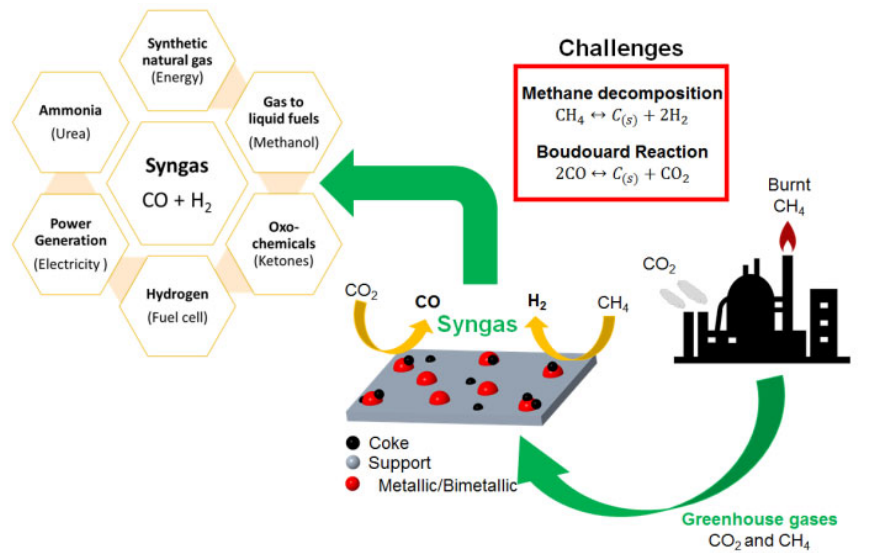
Figure 5 . A schematic illustration of the catalytic dry reforming of methane (DRM) reaction, with carbon dioxide as the oxidant, and the use of syngas.